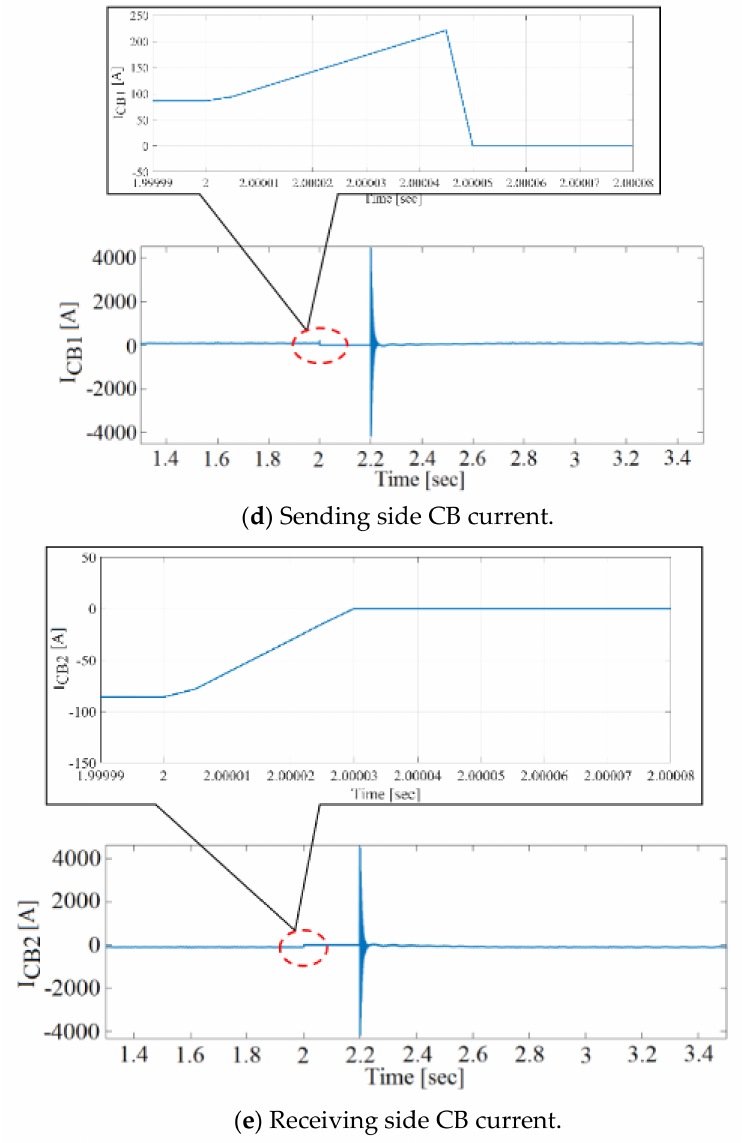
Figure 17. Simulation results of solid-state CB with freewheeling